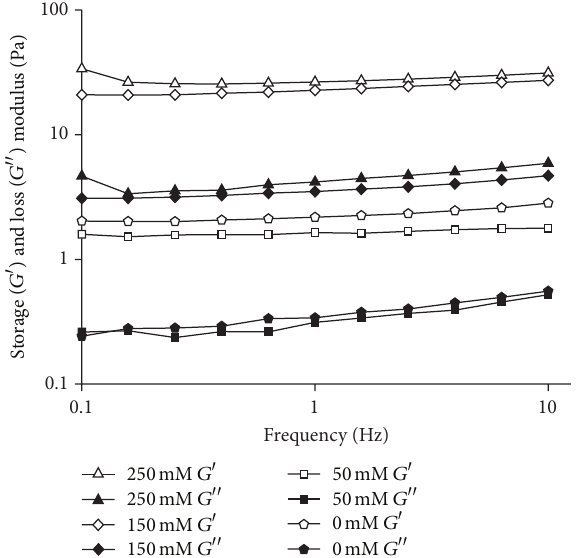
Figure 6: Frequency dependence of storage (𝐺 󸀠 ) and loss (𝐺 󸀠󸀠 ) modulus of 5% LP with different content of Na + .